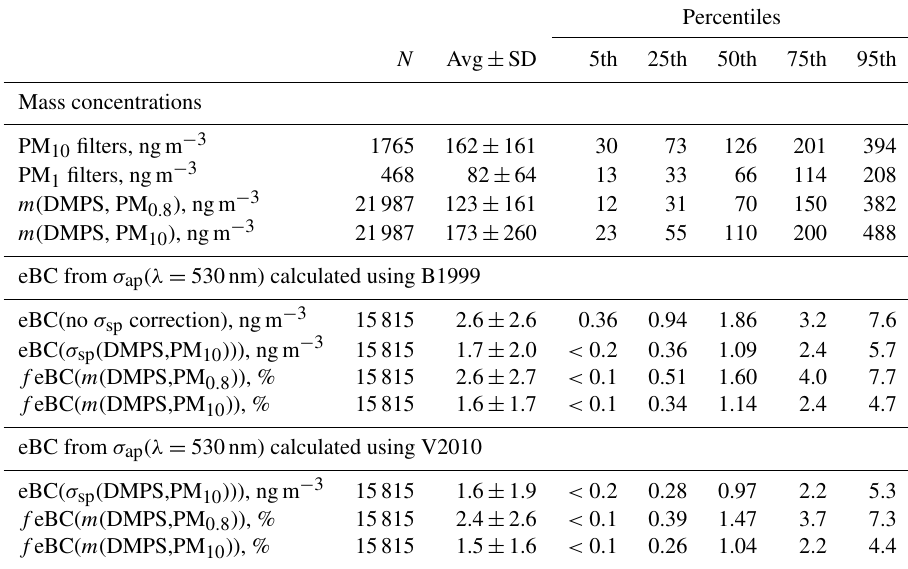
Table 4. Statistical summary of mass concentrations estimated from particle number size distributions, sums of ion concentrations of PM 1 and PM 10 filter samples, and the PSAP data at Dome C in 2008–2013. The statistical values of the PM 1 and PM 10 are those of all individual filters, and the statistical values calculated from the DMPS and PSAP data are those of running 24h-averaged data; see details in the text. m (DMPS,PM 0 . 8 ): mass concentration calculated from the particle number size distributions measured with the DMPS assuming a particle density of 1.7gcm − 3 ; eBC: equivalent black carbon concentration calculated from the absorption coef- ficients at λ = 530nm calculated by using the B1999 algorithm without any scattering corrections and with B1999 and V2010 al- gorithms using σ sp = σ sp (DMPS,PM 10 ) for the scattering corrections and assuming MAC = 7.78m 2 g − 1 . f PM 0 . 8 : scattering-corrected eBC mass fraction calculated from (eBC/ m (DMPS,PM 0 . 8 )) × 100%; f PM 10 : scattering-corrected eBC mass fraction calculated from (eBC/ m (DMPS,PM 10 )) ×